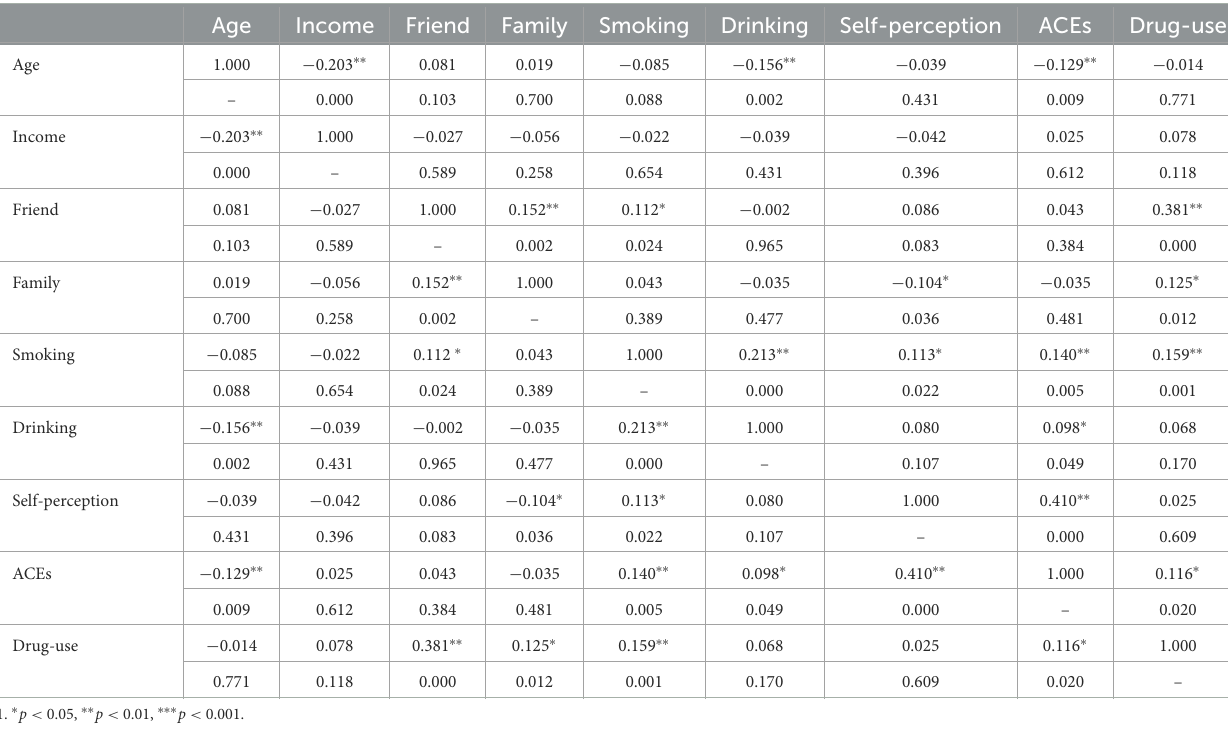
TABLE 2 Correlations between variables in the SEM model.